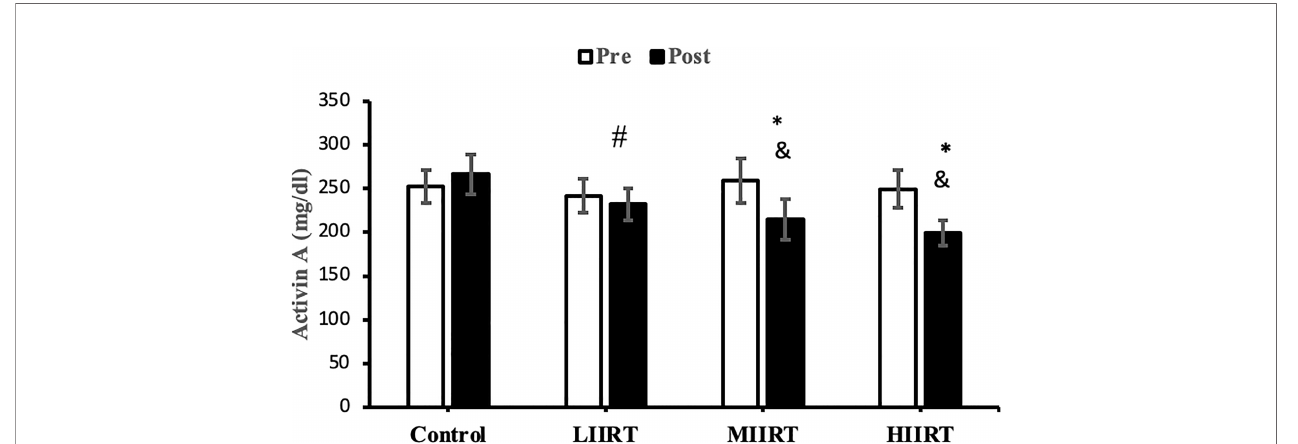
FIGURE 3 | Pre and post-training values (mean ± SD) for activin A in control, low-intensity interval resistance training (LIIRT), moderate-intensity interval resistance training (MIIRT), high-intensity interval resistance training (HIIRT) groups. *Signi fi cant differences from the control group (p<0.05). & Signi fi cant differences from pretest values (p<0.05). # Signi fi cant differences between training groups (p<0.05).